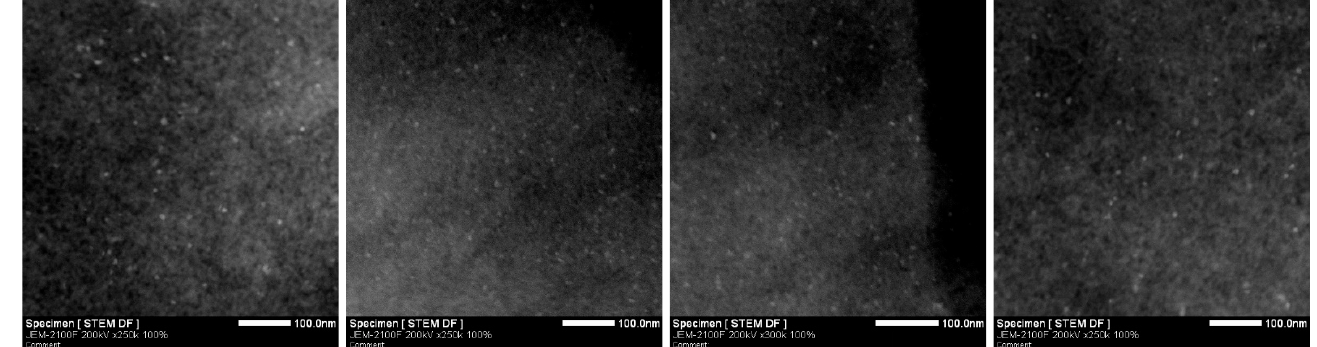
Figure 2. STEM images of the samples Pd/SO3H-Br-10, Pd/SO3H-Br-20, Pd/SO3H-Br-40, and Pd/SO3H-Br-50.